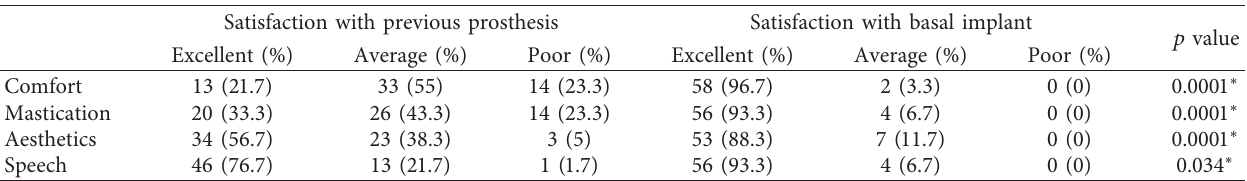
Table 5: Comparison of patients’ satisfaction with comfort, mastication, aesthetics, and speech with previous prosthesis and current basal